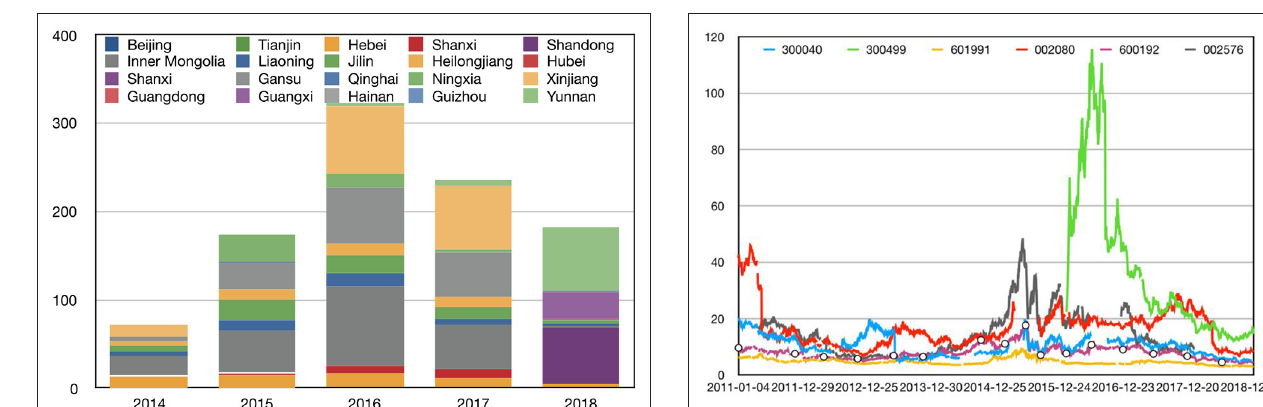
FIGURE 1 | Abandoned wind volume (100 million kWh).